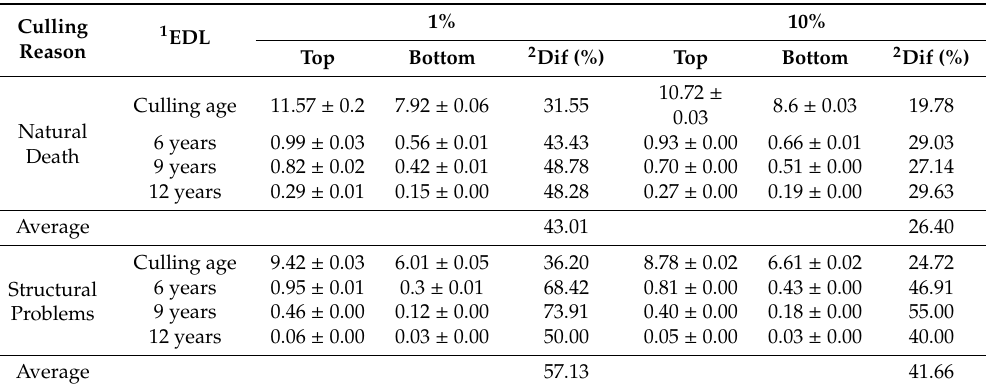
Table 9. Average ( ± SE) expected daughter longevity (EDL) predicted for the top and bottom 1% and 10% sires, considering di ff erent groups of known culling reasons and selection at 4 years-old for traditional